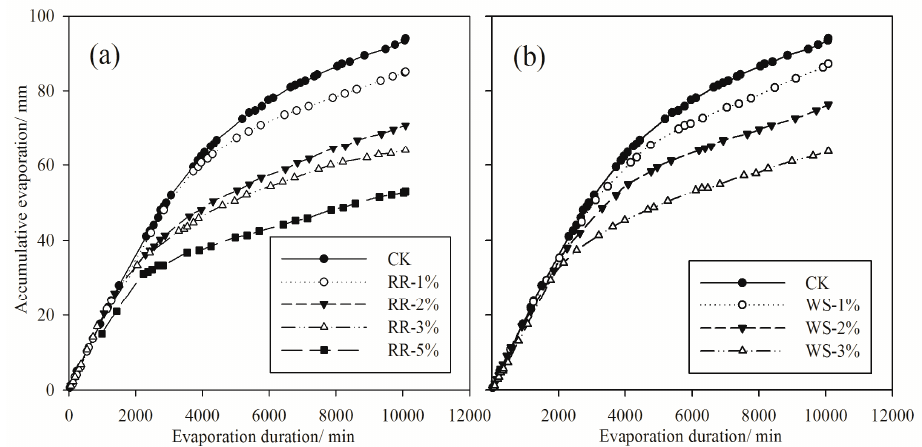
Figure 3. Relationship between accumulative evaporation and duration with various quantities of applied rapeseed-oil residue (RR) and wheat straw (WS): ( a ) Represents the treatments mixed with RR; ( b ) Represents the treatments mixed with WS.